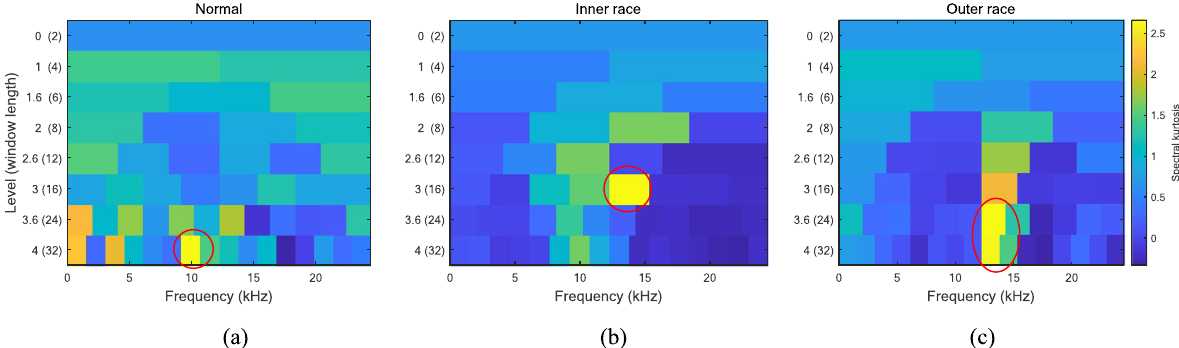
Figure 17 The paving spectral kurtosis values and their associated frequency bands for signals in different states: a normal state (the optimal central frequency is 9.92 kHz); b inner race fault (the optimal central frequency is 13.73 kHz); c outer race fault (the optimal central frequency is 13.22 kHz)